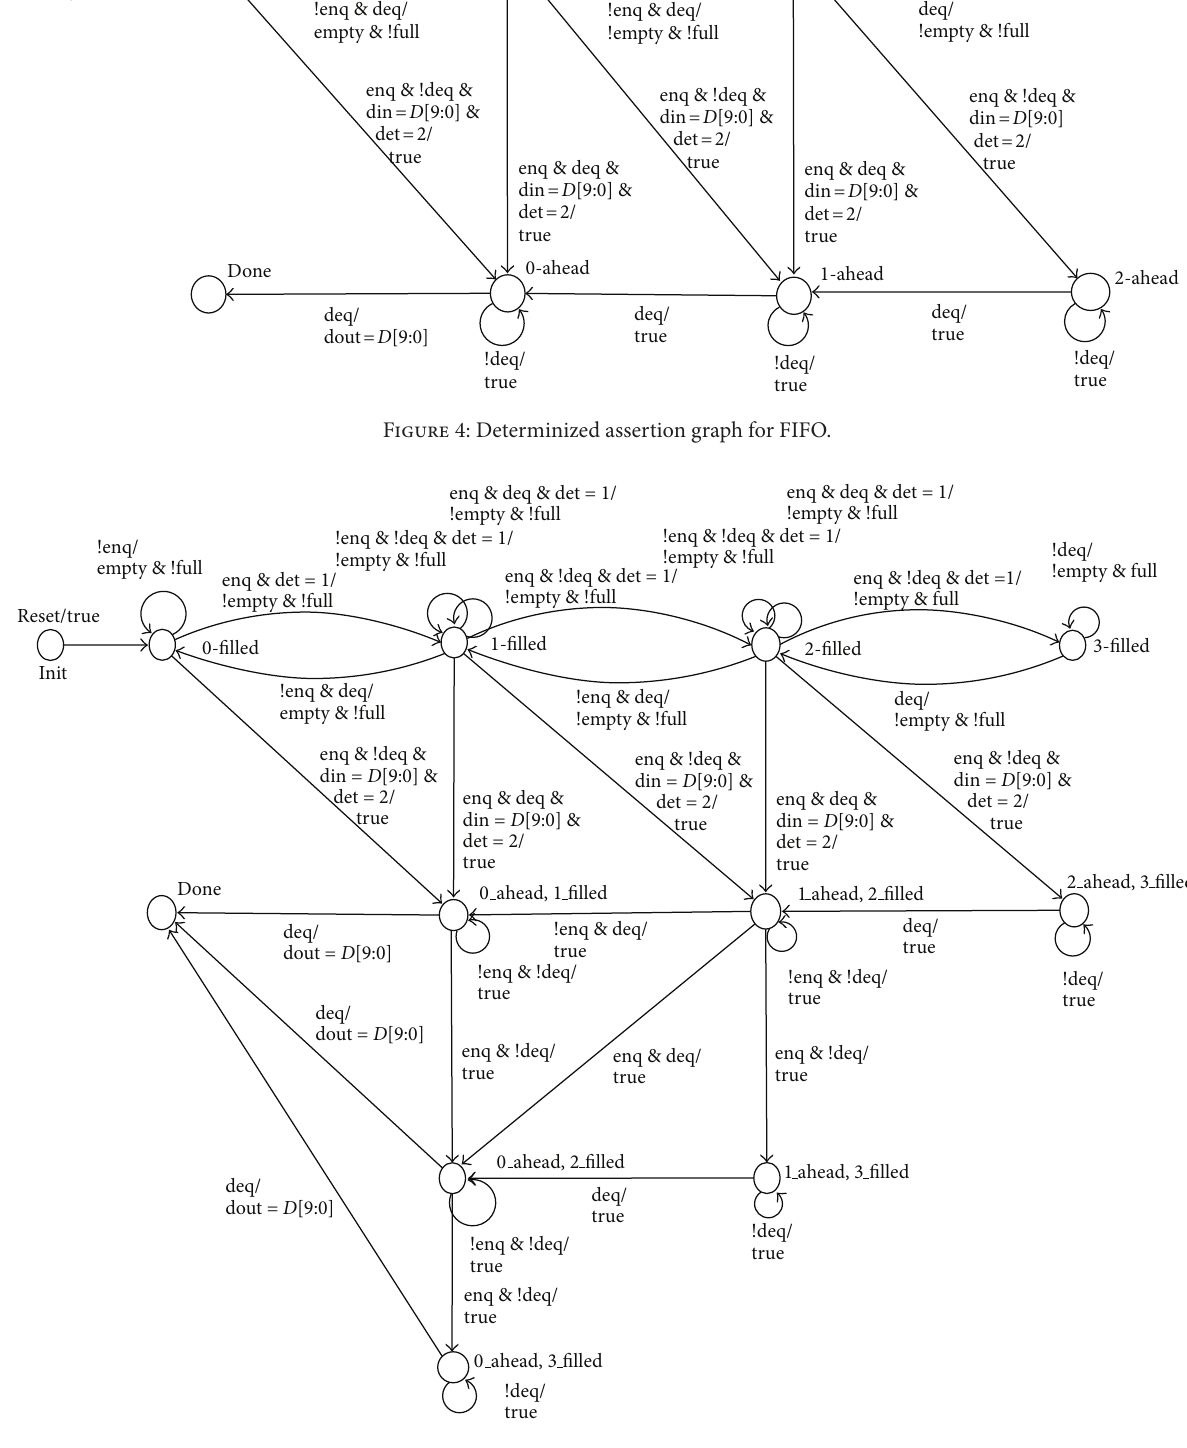
Figure 5: Determinized and refined assertion graph for